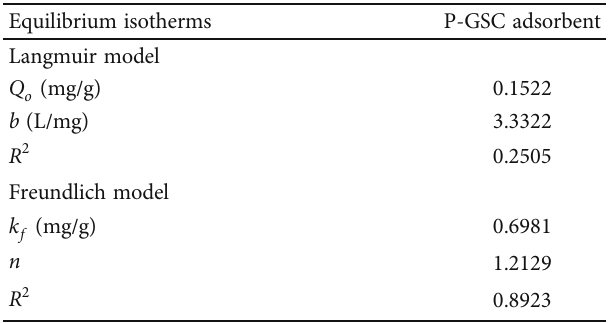
Figure 6: Adsorption capacity graph with di ff erent weights of small-sized P-GSC ( volume = 250 mL, concentration of MB dye solution = 20 mg/L, mixing speed = 230 rpm, and room temperature). Table 1: Equilibrium isotherms for small-sized